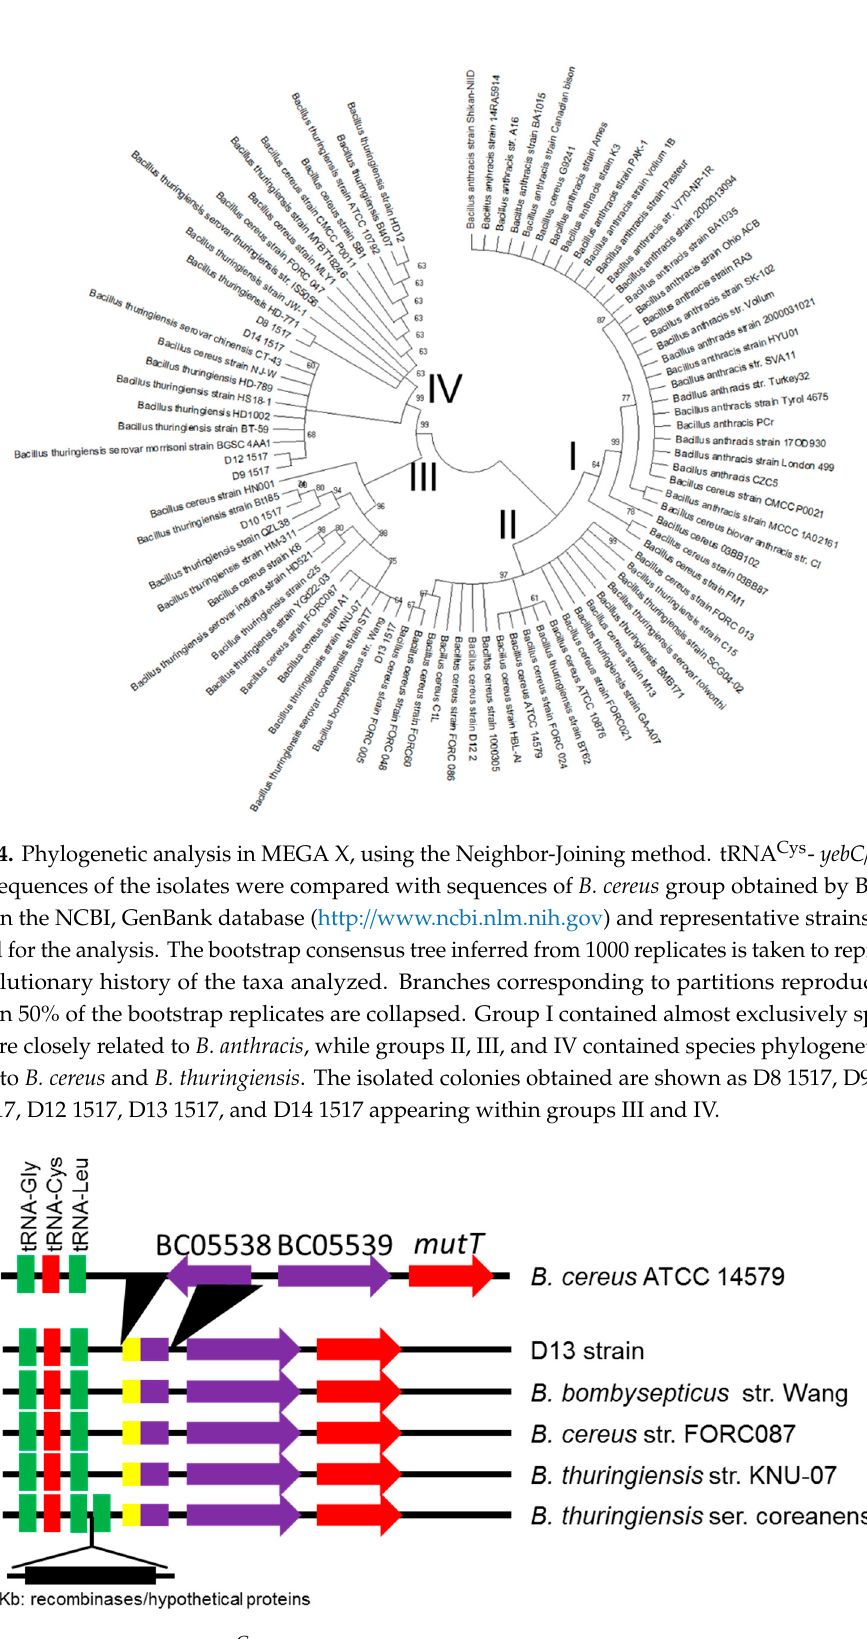
Figure 5. Analysis of the tRNA Cys region for strain D13 and species closely related phylogenetically. Deletion of sequences is indicated by black triangles compared with B. cereus ATCC 14579. Insertion of ~30 Kb for B. thuringiensis ser. coreanensis is indicated by the black rectangle. The yellow color indicates insertion sequences detected.